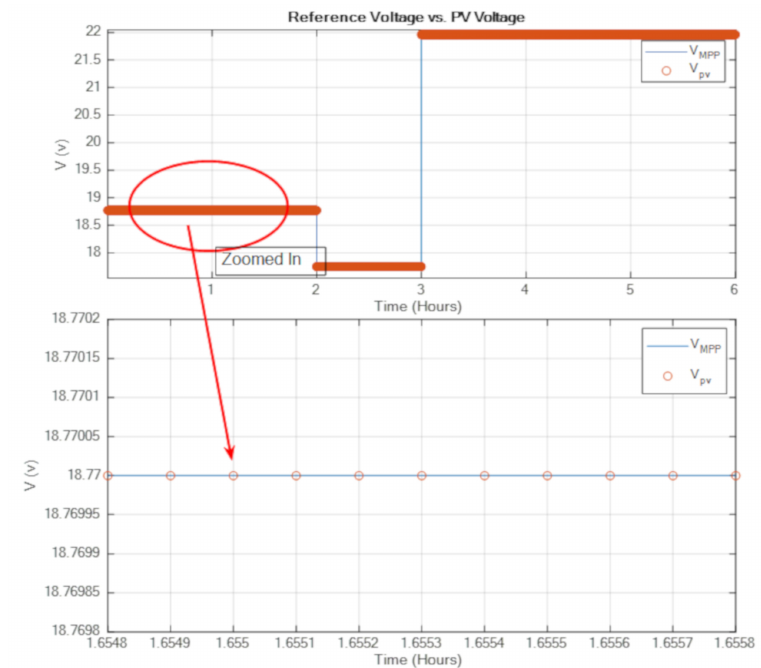
Figure 13. PID regulator pushes V PV to follow (cid:101) V MPP